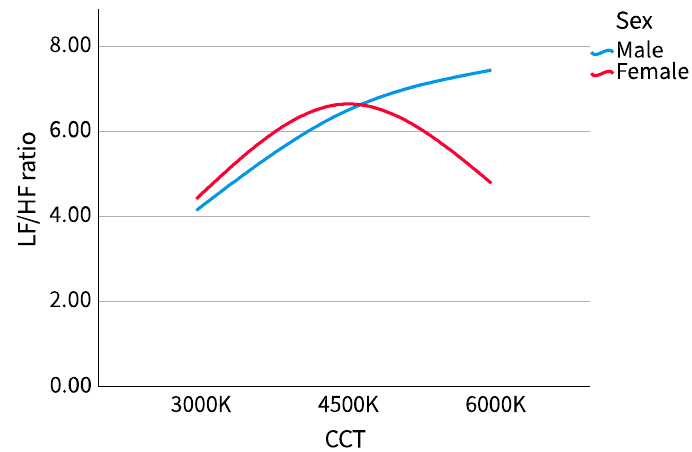
Figure 6. LF/HF ratio line chart (sex).